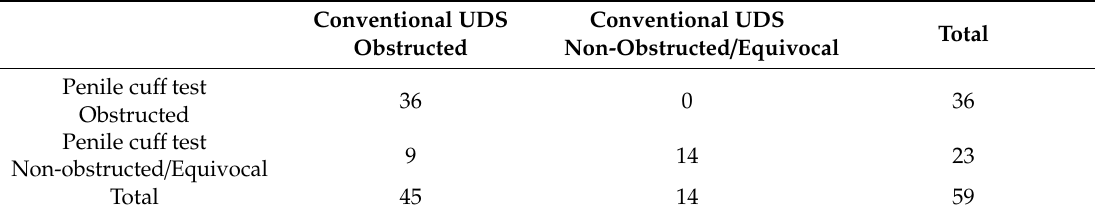
Table 2. A comparison of the data from the penile cu ff test and conventional urodynamic study (UDS).